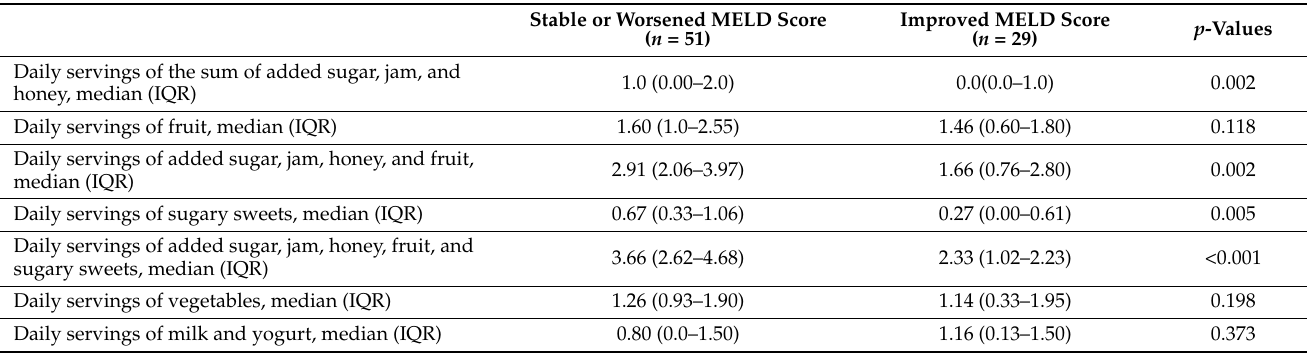
Table 3. Number of servings of foods containing simple sugars eaten per day by patients with cirrhosis according to changes in MELD score over time.